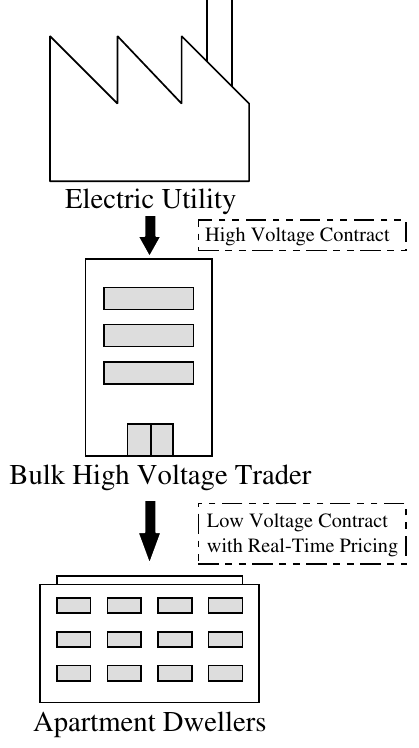
Figure 2. The proposed contract